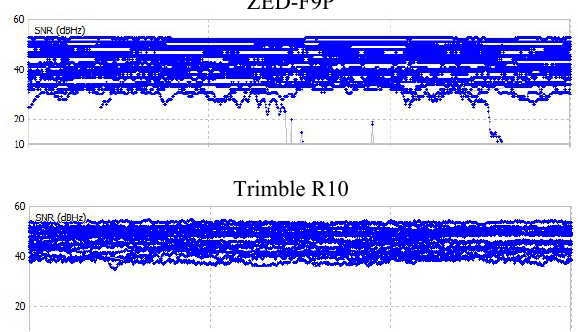
Figure 3 : Comparison of the signal-to-noise ratio obtained with the two receivers on the frequency